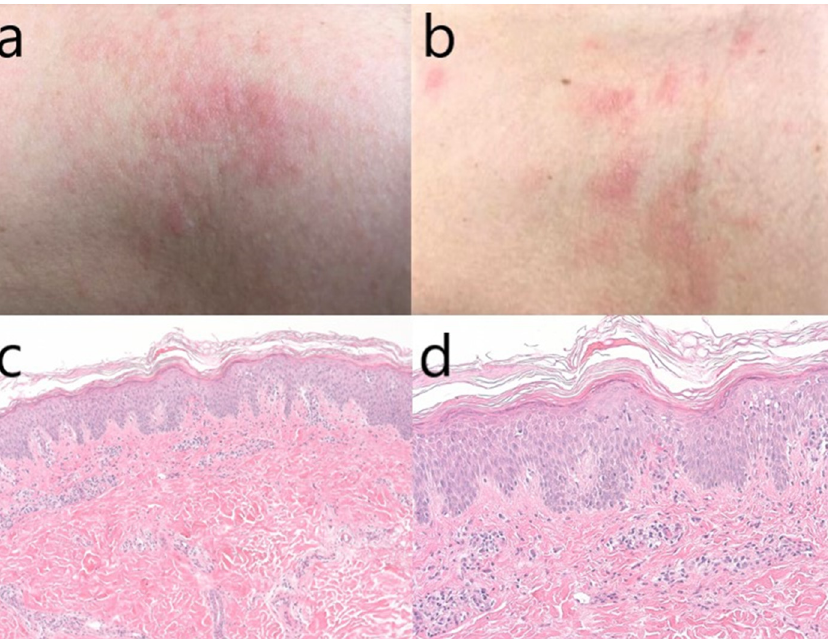
Figure 1. ( a – d ) Macroscopic aspect of the skin lesions from the neck and thorax ( a , b ); skin biopsy– hematoxylin & eosin stain, original magnification 100× ( c ); magnification 200× ( d ). We can observe hyperkeratosis, marked acanthosis (psoriasiform hyperplasia) with focal lymphocytic exocytosis, minimal epidermal edema, perivascular and interstitial lymphocytic infiltrate, which are histopathological signs compatible with subacute chronic spongiotic dermatitis.